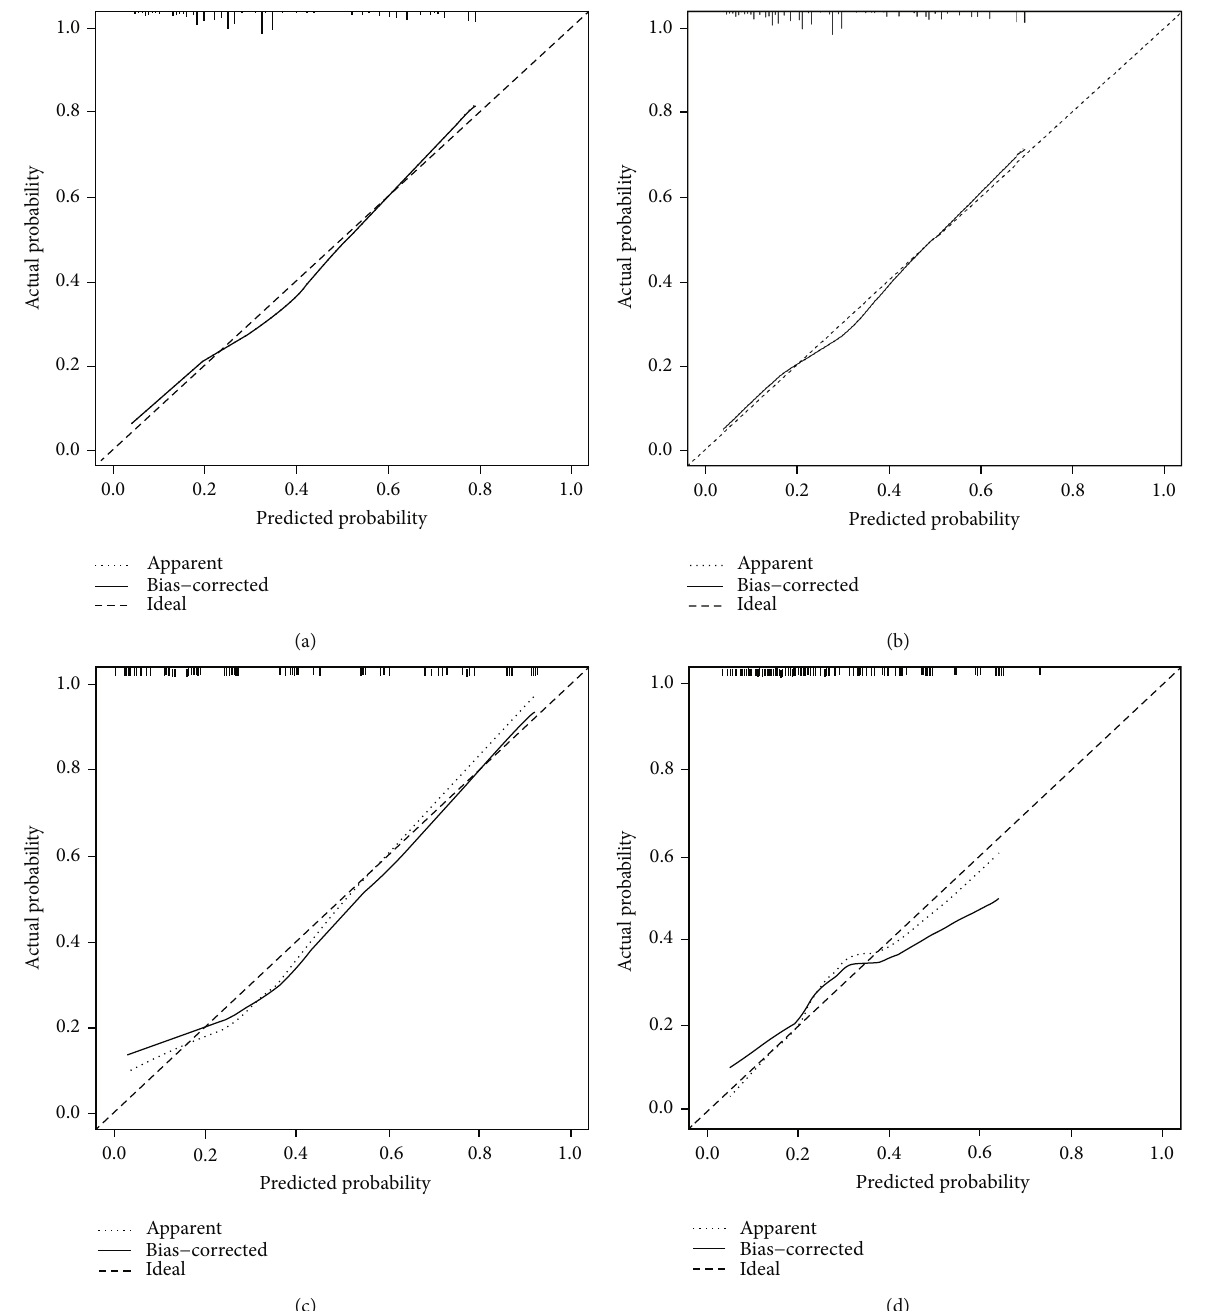
Figure 3: The calibration plots for the nomogram of overall early death (a) and speci fi c early death (b) in the SEER database. The calibration plots for the nomogram of overall early death (c) and speci fi c early death nomogram (d) in the validation